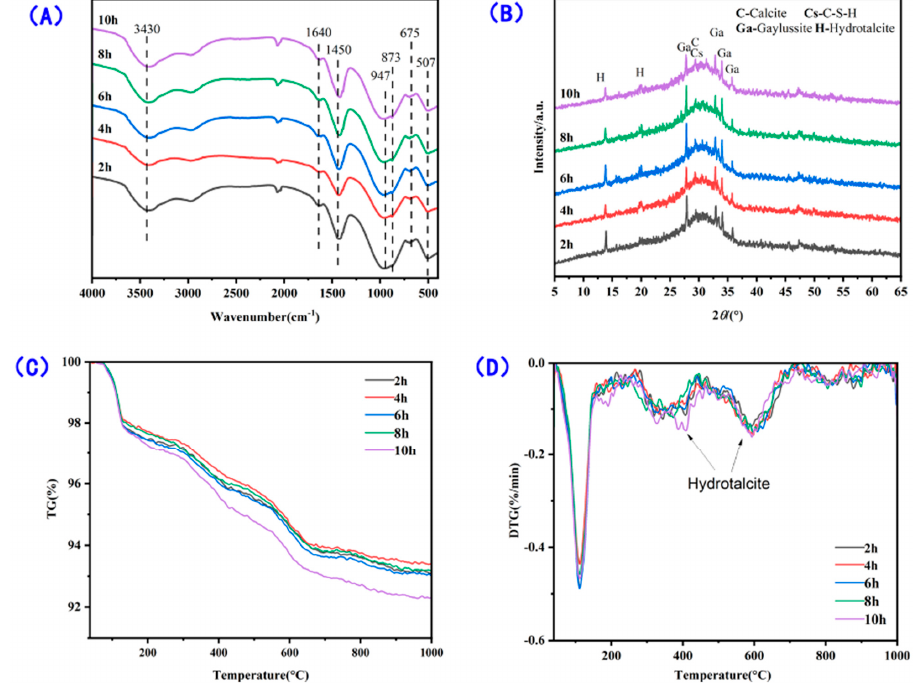
Figure 8. Early age hydration of samples with 4% of C-S-H seeds as a function of time: ( A ) infrared spectroscopy, ( B ) phase characterization, ( C ) mass loss at different temperatures, and ( D ) derived thermal gravity of samples.